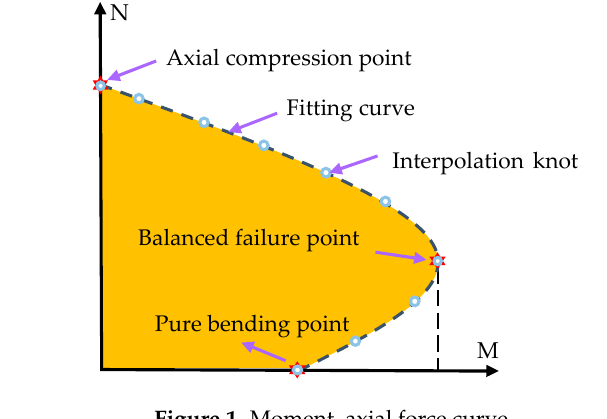
Figure 1. Moment–axial force curve.